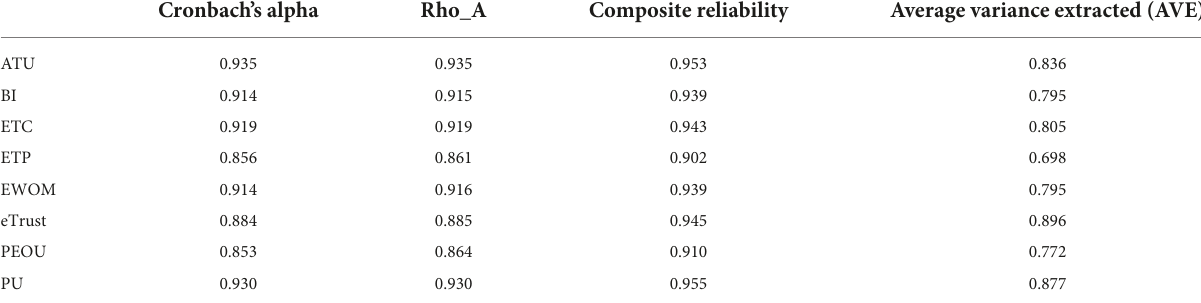
TABLE 2 Composite reliability of the major